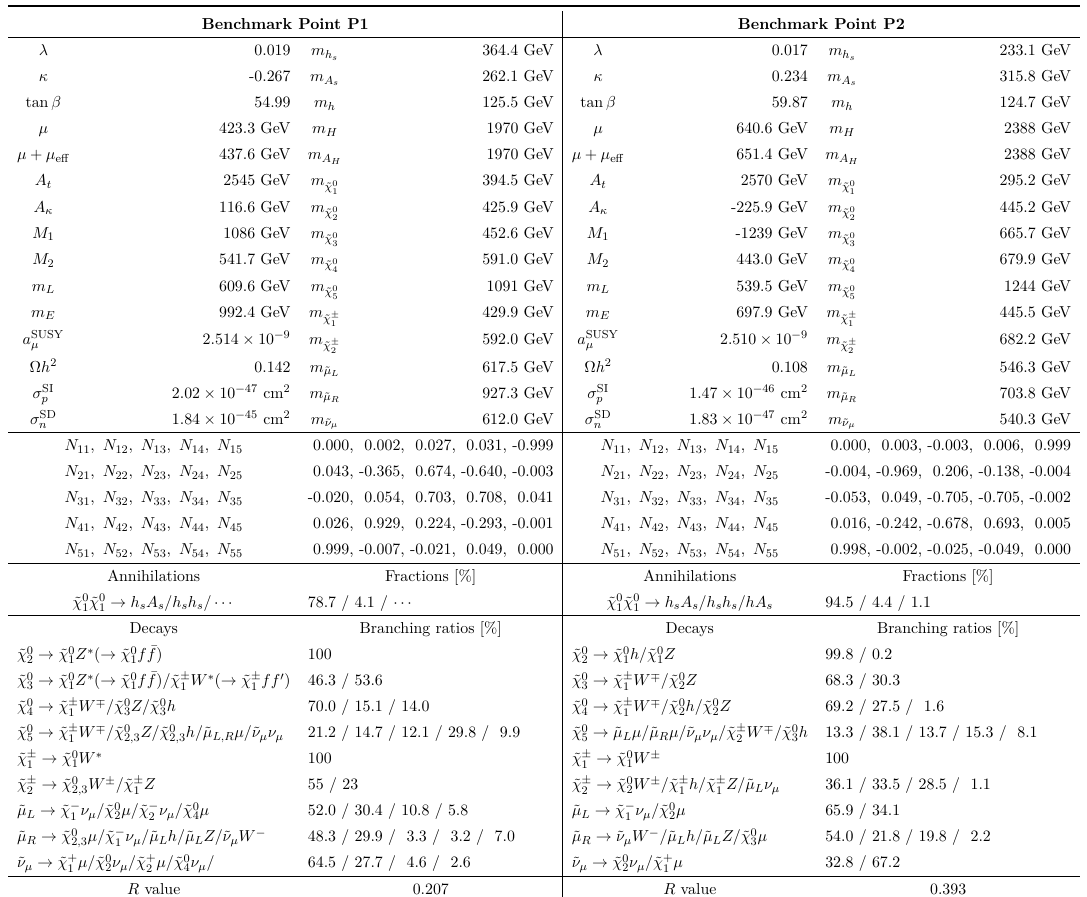
Table 2 . Detailed information of two benchmark points that agree well with all of the DM and Higgs experiments and predict a SUSY ’ 2 . 51 × 10 − 9 . Numbers after annihilation processes represent their µ fractions in contributing to total DM annihilation cross-section at freeze-out temperature. Numbers after sparticle decay channels denote their branching